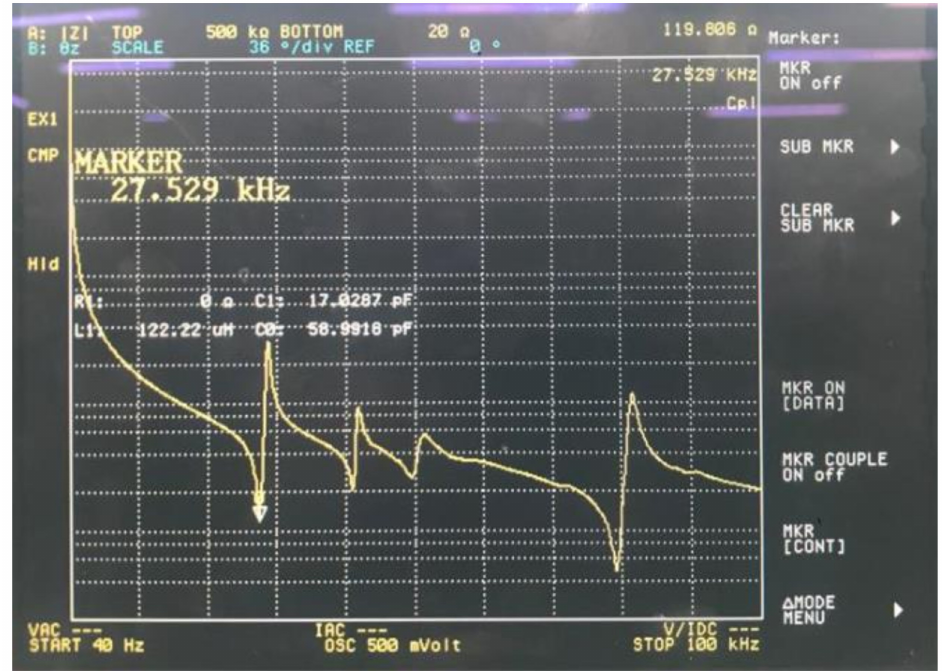
Figure 4. Marinised transducer, main resonance frequency is 27.5 and 119.8 Ohms.